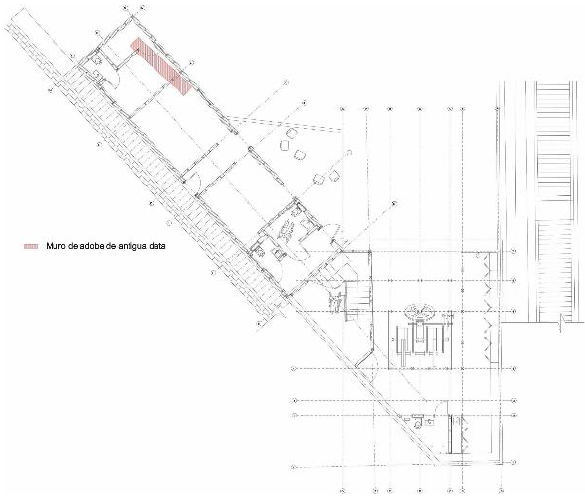
Figure 14. Plan of the upper station with the archaeological finding.